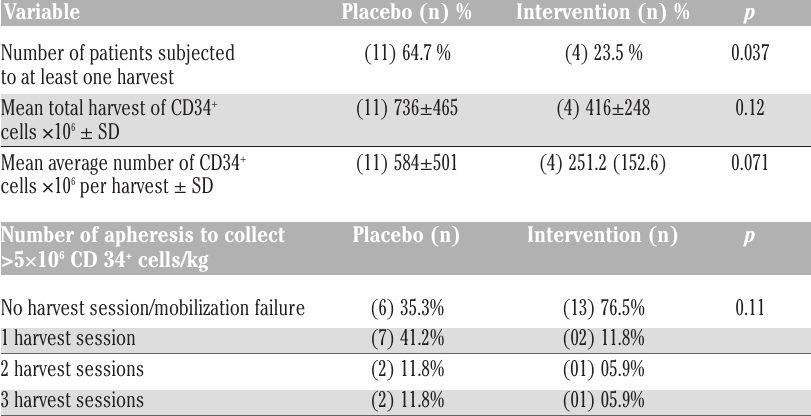
Table 2. Fraction of patients subjected to harvest of an autograft (phase